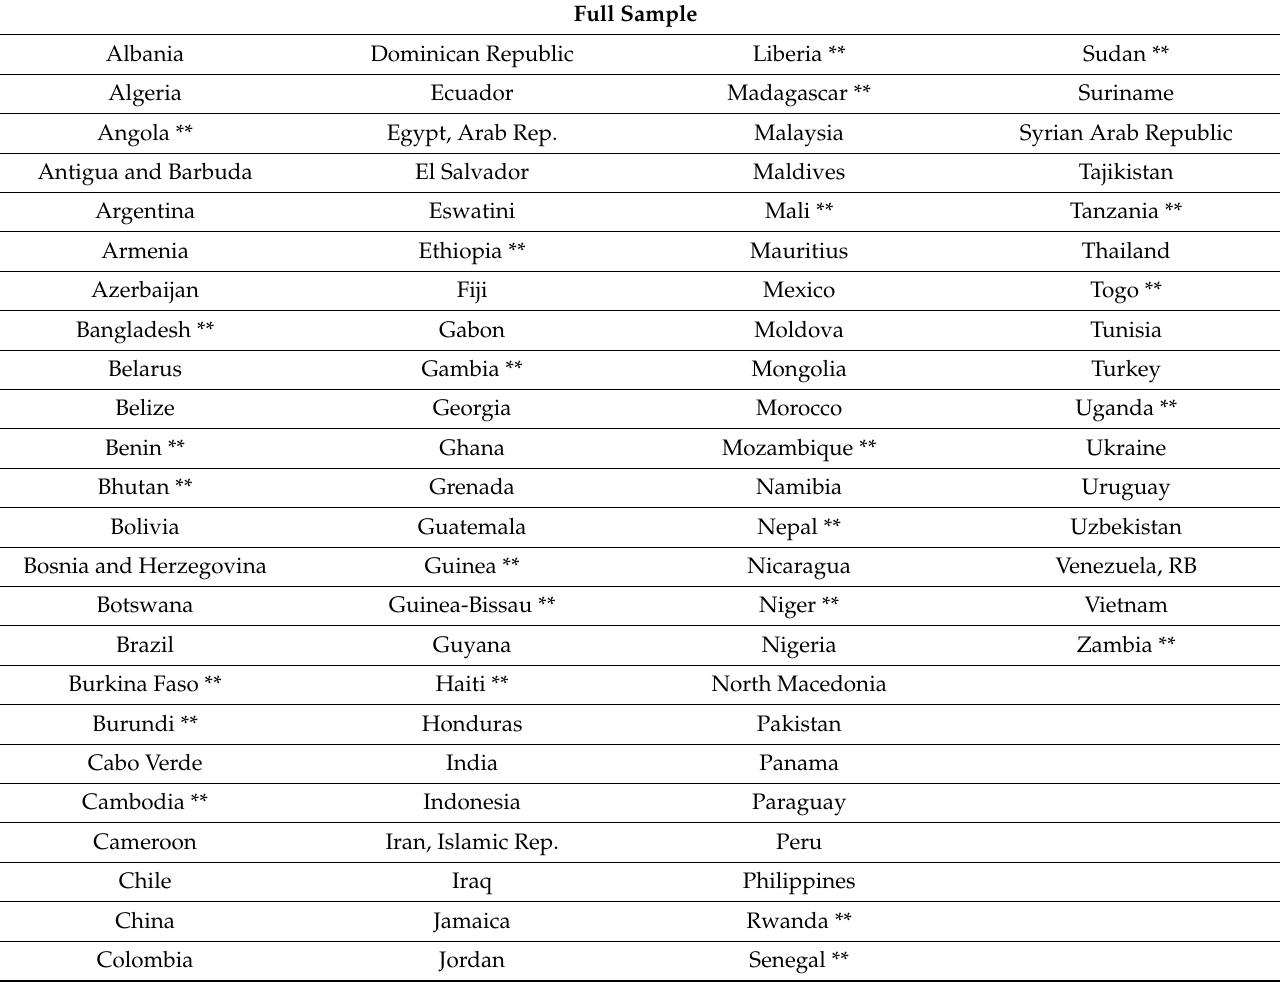
Table A3. List of the 106 countries used in the full sample, 30 of which are LDCs. Full